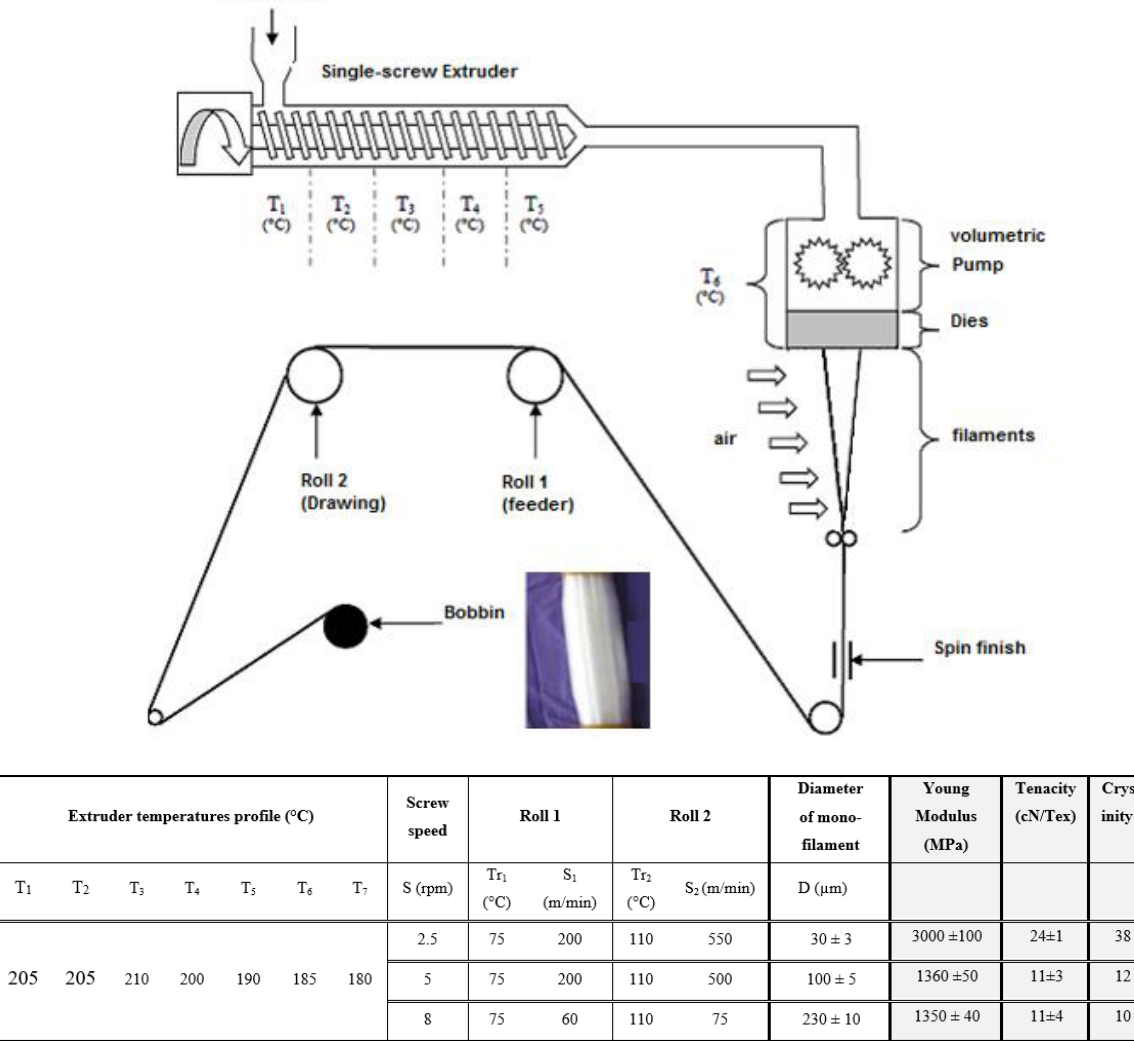
Figure 2. Melt – spin process diagram. The parameters of melt – spin to obtain PLLA filaments of various diameters are given in the table. In grey shading, data for the physical and mechanical properties of each filament are given.